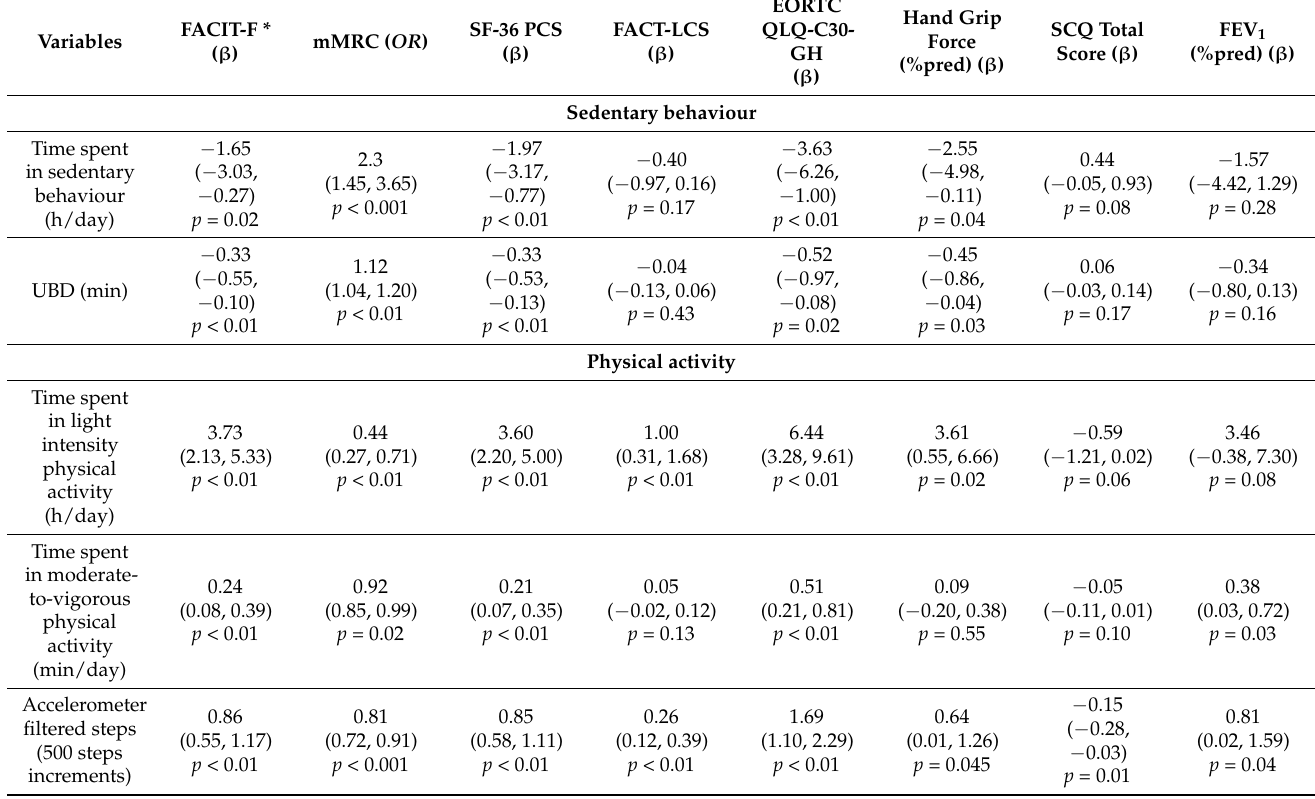
Table 4. Associations between sedentary behaviour/physical activity variables and symptoms (FACIT-F and merch), HRQoL, muscle force, comorbidities, and lung function. Values adjusted for age, gender, BMI, lung cancer stage, NLR, and waking wear time